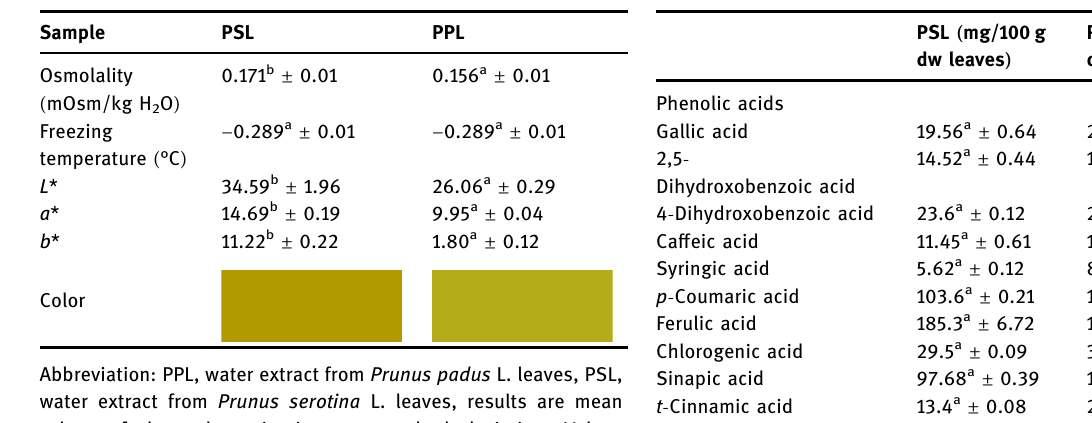
Table 2: Content of polyphenolic compounds in P. serotina and P. padus leaves